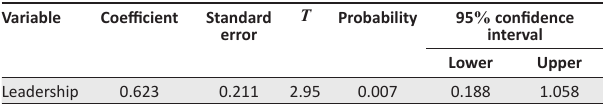
TABLE 3b: Regression